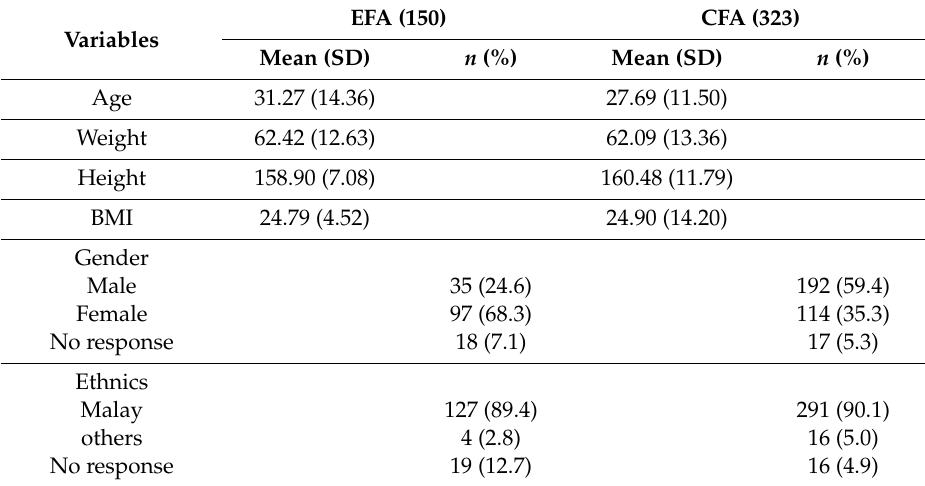
Table 1. Demographic characteristics for participants in EFA and